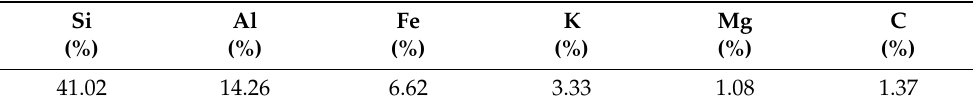
Table 3. Chemical elements of the expansive soil.